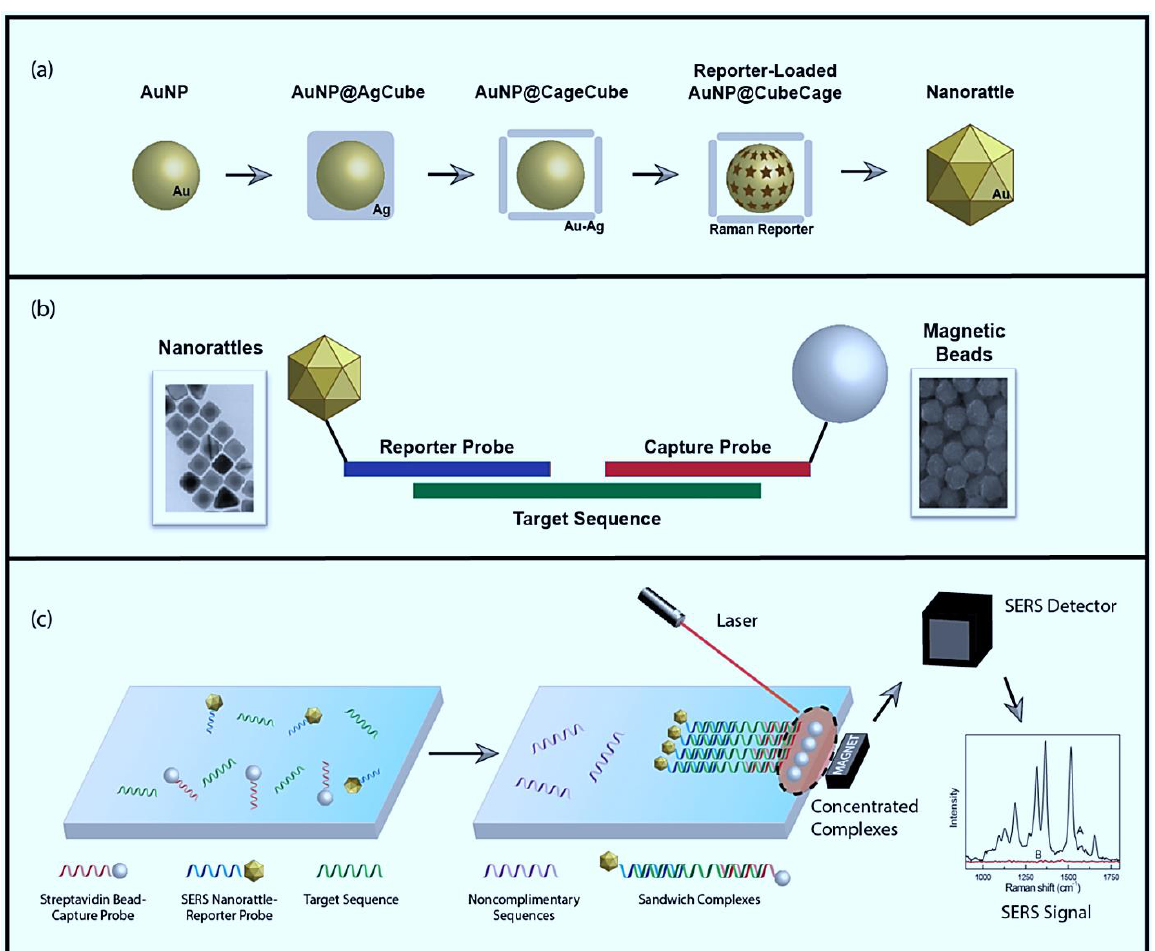
Figure 4. SERS diagnostic process summary. ( a ) Synthesis of cubic nanorattles, beginning with single-crystal, spherical gold nanoparticle (AuNP) cores. The AuNP cores are coated with cubic Ag shells to obtain AuNP@AgCube. Galvanic replacement transforms cubic Ag shells into cubic Au–Ag cages containing AuNP in the interior. Raman reporters are loaded, and the porous cubic cages are turned into complete shells by a final Au coating to obtain cube nanorattles. ( b ) Structure of individual hybridization complex. Gold nanorattles (Au-NR) are functionalized with DNA reporter probes, and streptavidin beads are functionalized with DNA capture probes. Both probes are complimentary to the specific cytokeratin sequence. ( c ) Extracted nucleic acids are incubated with functionalized nanorattles and beads, then washed away. Remaining complexes undergoing successful hybridization are isolated using a strong magnet and concentrate to a spot for laser excitation in order to yield a SERS signal. Reproduced from [205].